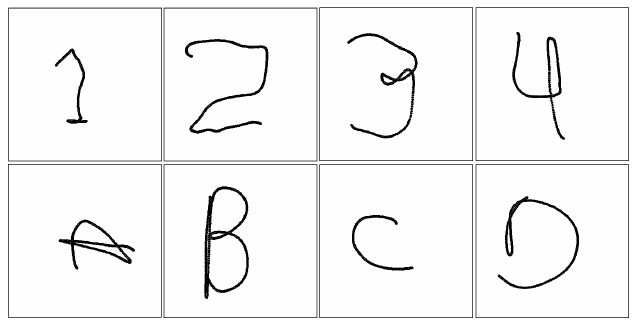
Figure 7. Samples of images generated from the studied